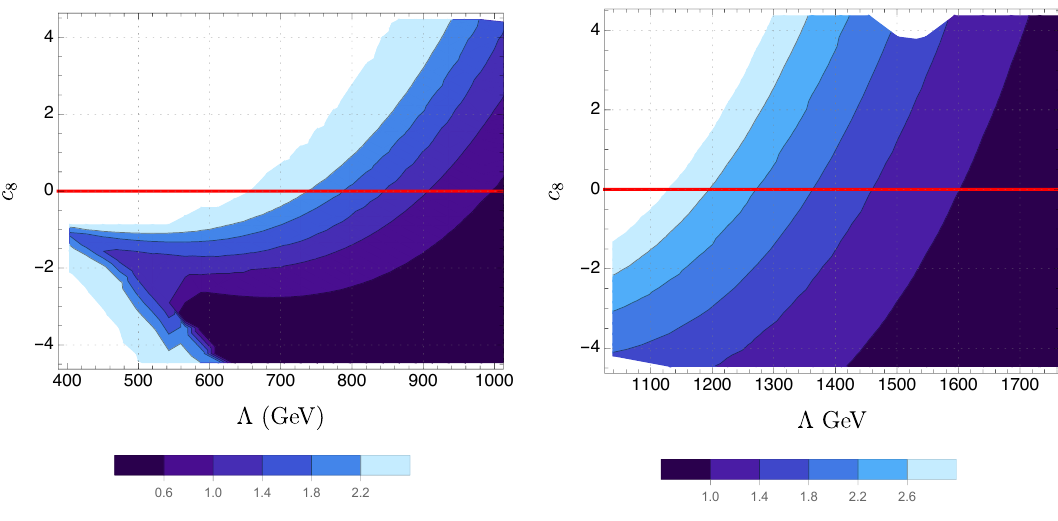
as function of Λ and c in 8 T N = 80 GeV and all other parameters as in h D